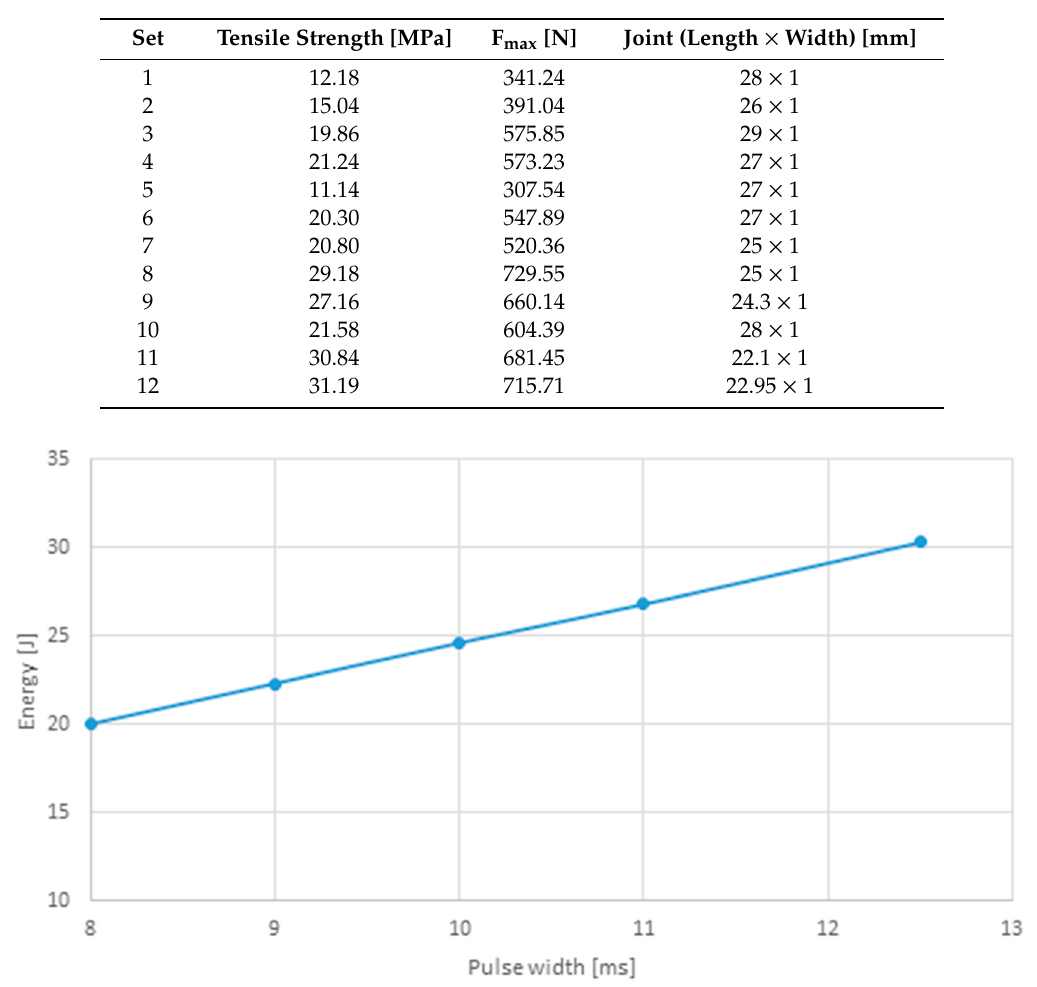
Table 5. Results of the tensile tests: tensile strength, maximum force and joint dimensions (length × width) for each set of parameters.